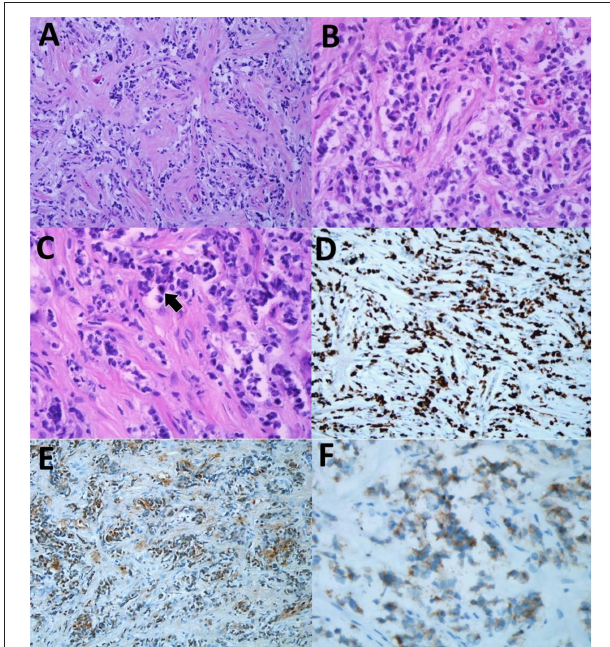
FIGURE 4 | (A) The lesion showed moderate neoplastic cells with background desmoplastic and myxoid changes. (H&E, original magnification × 20). (B) The cells were fairly monomorphic with mild nuclear pleomorphism displaying enlarged round to oval nuclei with fine nuclear chromatin and inconspicuous nucleoli hematoxylin and eosin (H&E), original magnification × 40). (C) Occasional mitosis was seen (arrow) (H&E, original magnification × 40). (D) High Ki-67 proliferation rate of the neoplastic cells (immunohistochemical (IHC) Ki-67, original magnification × 20). (E) The neoplastic cells were positive for S100 (IHC S100, original magnification × 20). (F) The cells showed positivity toward synaptophysin immunostain (IHC synaptophysin, original magnification ×